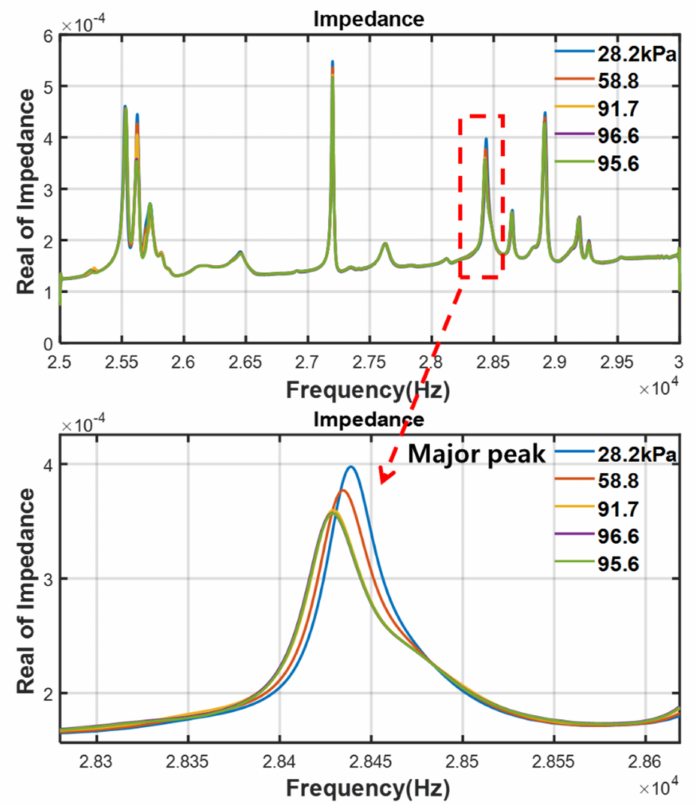
Figure 5. Variations in EMI according to internal pressure (test